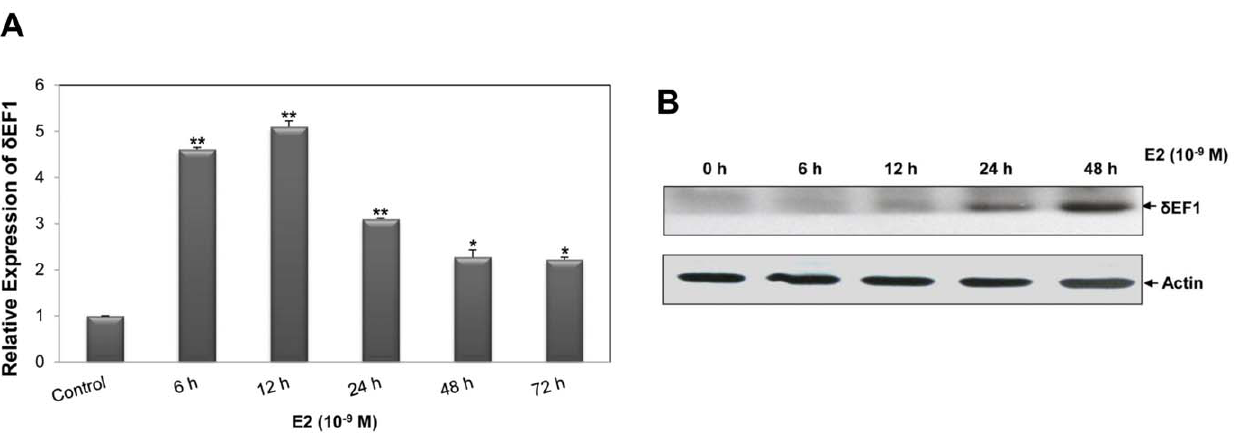
Figure 1. E2 treatment up-regulates d EF1 expression in MCF-7 cells. A. MCF-7 cells were treated with 10 2 9 M E2 at the indicated time points. The up-regulation of d EF1 mRNA was verified by Q-PCR. GAPDH was used to normalize the d EF1 level. * indicates p , 0.05 in unpaired Student’s t-test compared with the control. ** indicates p , 0.01 in unpaired Student’s t-test compared with control. The data represent three independent experiments. B. MCF-7 cells were treated with 10 2 9 M E2 at the indicated time points. The expression of d EF1 protein was verified by Western Blot. Actin was used to normalize the d EF1 level.